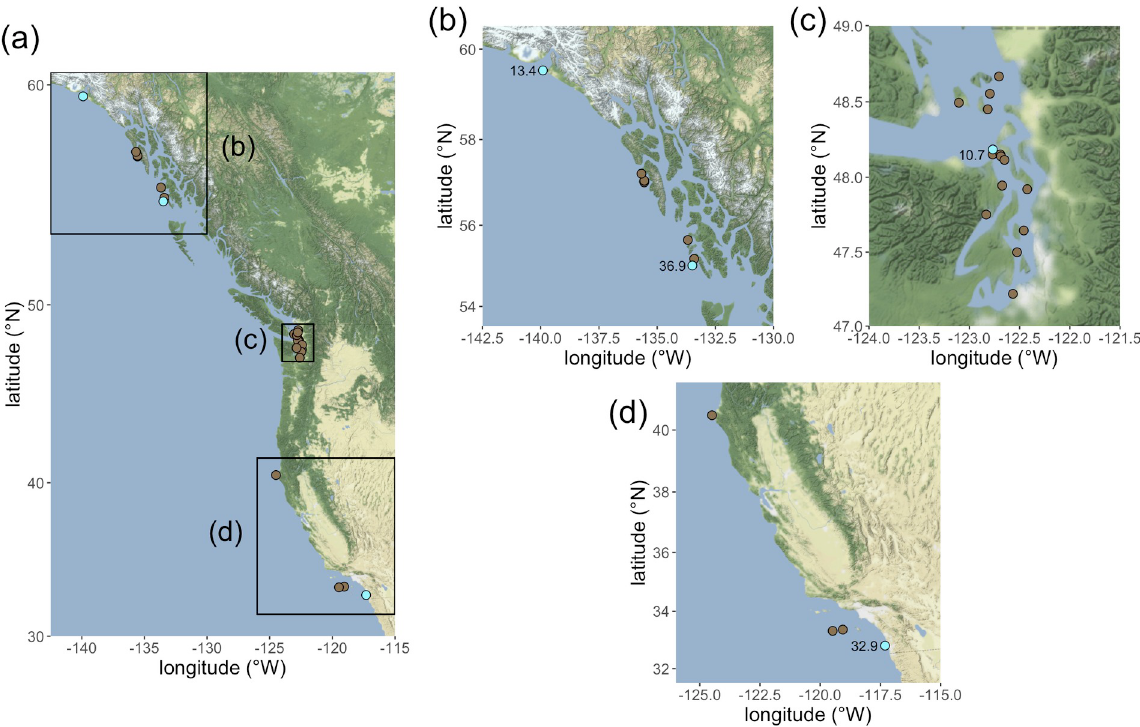
Fig 2. Map of study region with sampling sites indicated. Sites where any blue male (total n = 4) was collected are indicated in blue; sites that yielded only brown males are indicated in brown. The depth of collection of each blue male is noted (in meters). (a) Full study extent with insets displaying the boundaries of maps (b), (c), and (c). Sampling sites in (b) Alaska, (c) Puget Sound, Washington, (d) northern and southern California. Site locations in Puget Sound are jittered to allow better visualization of nearby sites.